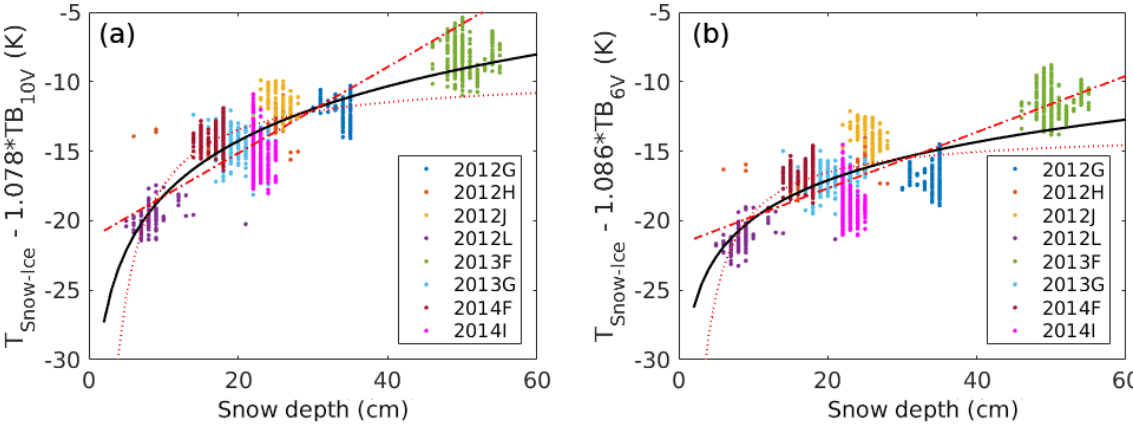
Figure 7. T Snow − Ice corrected for the 10V TB (a) and of the 6V TB (b) dependence as a function of snow depth. Data from the IMBs are represented by different colours, the regression using the snow depth is shown by the dashed red line, the regression using the inverse of snow depth by the dotted red line, and the regression using the logarithm of the snow depth by the solid black